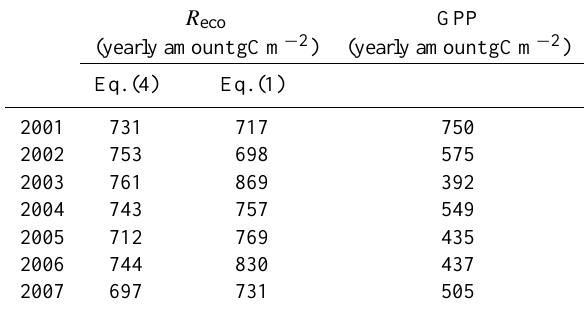
Table 5. Carbon budget of the SMOSREX grassland derived from the ISBA-A-gs simulations from 2001 to 2007: yearly amounts of ecosystem respiration ( R eco ) and Gross Primary Production